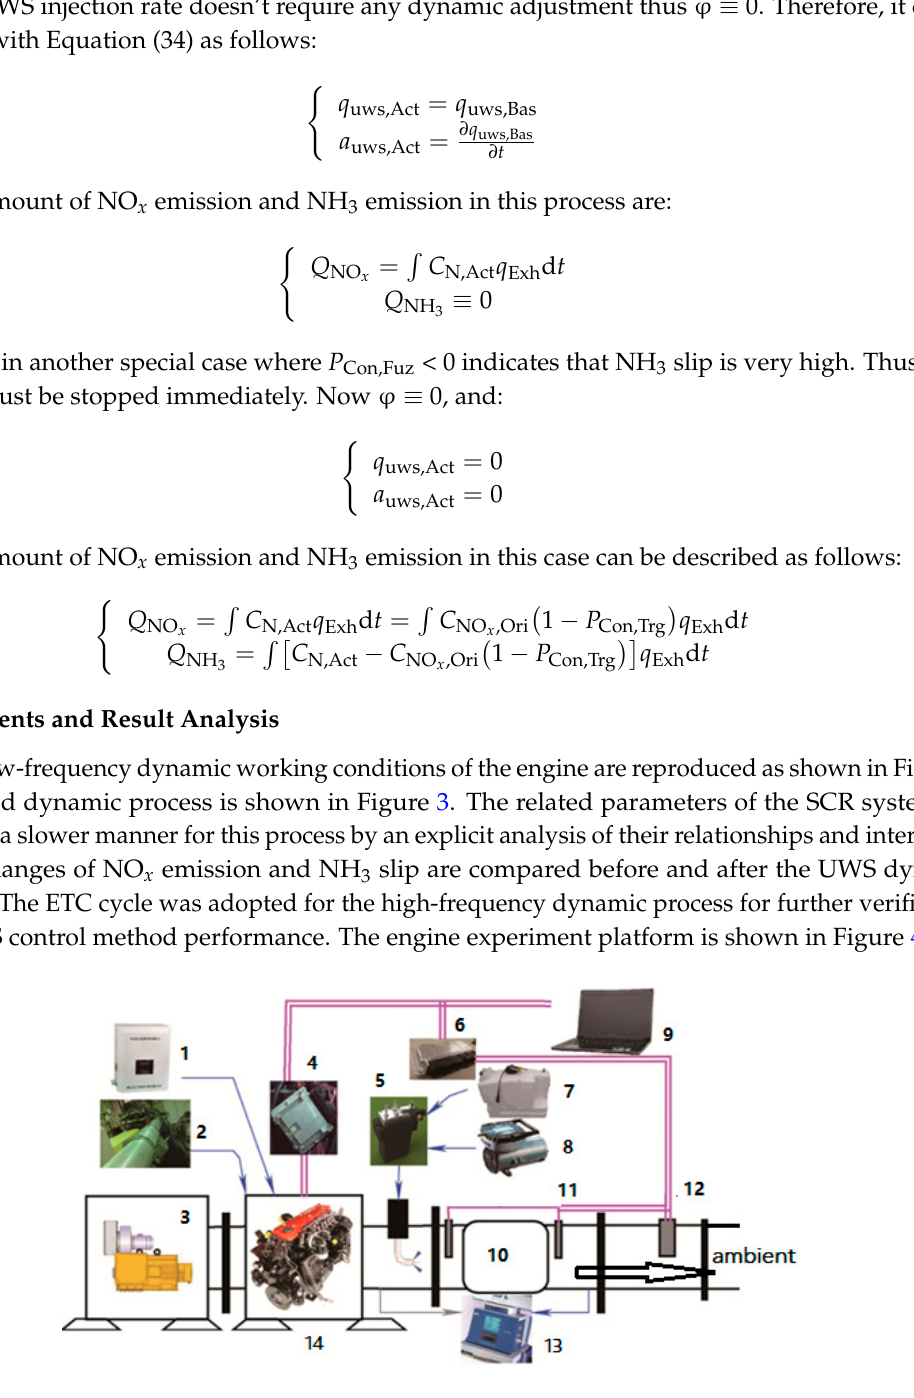
Figure 4. Engine experiment platform block diagram. 1: Fuel consumption; 2: Air flowmeter; 3: Dynamometer; 4: Electronic control unit (ECU); 5: Unified diagnostic services (UDS); 6: SCR control unit (SCU); 7: UWS tank; 8: Air pump; 9: Monitor; 10: Exterior gateway protocol (EGP); 11: Temperature sensor; 12: NO x sensor; 13: Emissions analyzer; and 14: Diesel